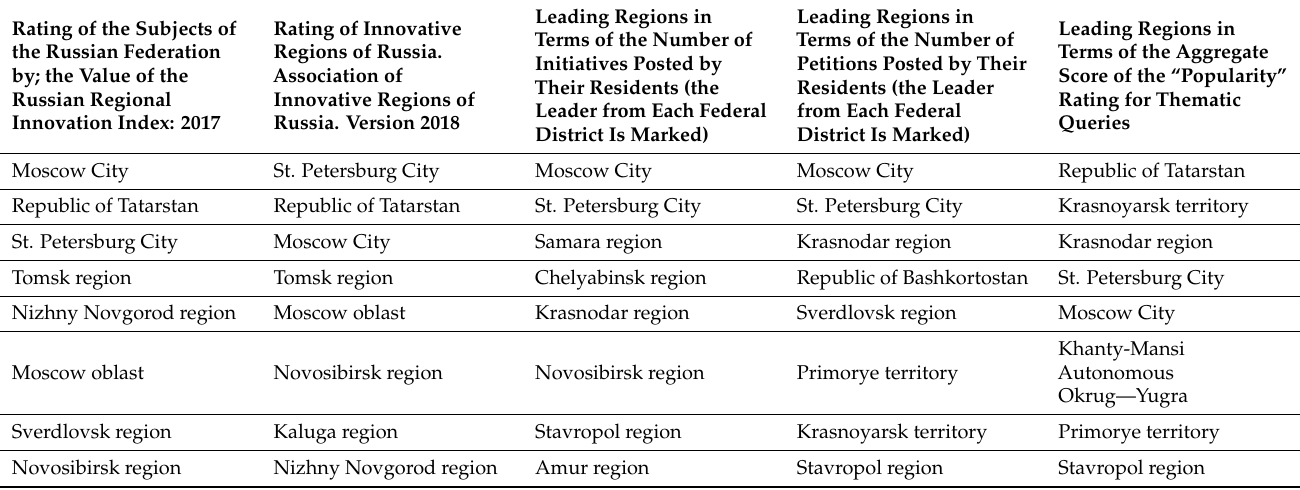
Table A1. Leading regions